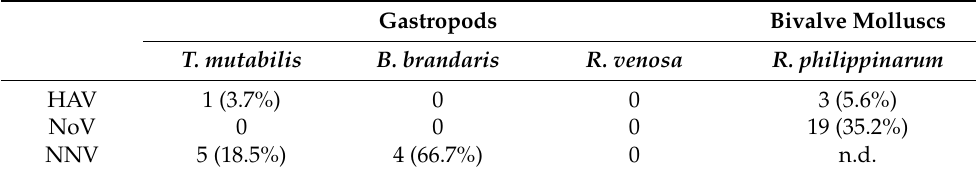
Table 2. Results of the virological investigation.